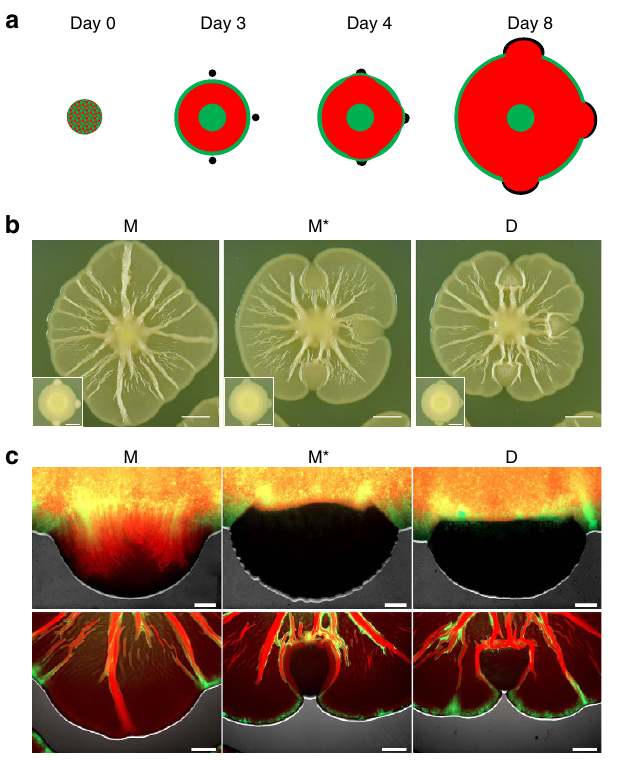
Figure 5 | M functions as a lubricant allowing D to push from behind. ( a ) Schematic of the spatial structure construction experiment. Fluorescently labelled M (green) and D (red) cells are mixed 1:1 and spotted. M and D self-organize and spatially segregate, establishing the characteristic spatial structure. Droplets of unlabelled M, M* (no mucoid polymer) or D cells are then placed near the edge of the spreading front on day 3 and visualized on days 4 and 8. ( b ) Spreading continues when the mixed colony encounters a droplet of M, but not M* or D. Main images were captured on day 8 and the inset images show the spatial arrangements on day 4. Scale bars, 5mm. ( c ) The red-labelled D strain streams into the droplet of cells and pushes the colony edge along, but only when the droplet cells are the mucoid M strain. Epifluorescence images on day 4 (top; 0.5mm scale) and day 8 (bottom; 2mm scale). D continues to push through M, but not M* or D. These images correspond to the bottom droplets shown in b . See also Supplementary Fig. 3 for more detail on the key treatment where D streams into mucoid M.